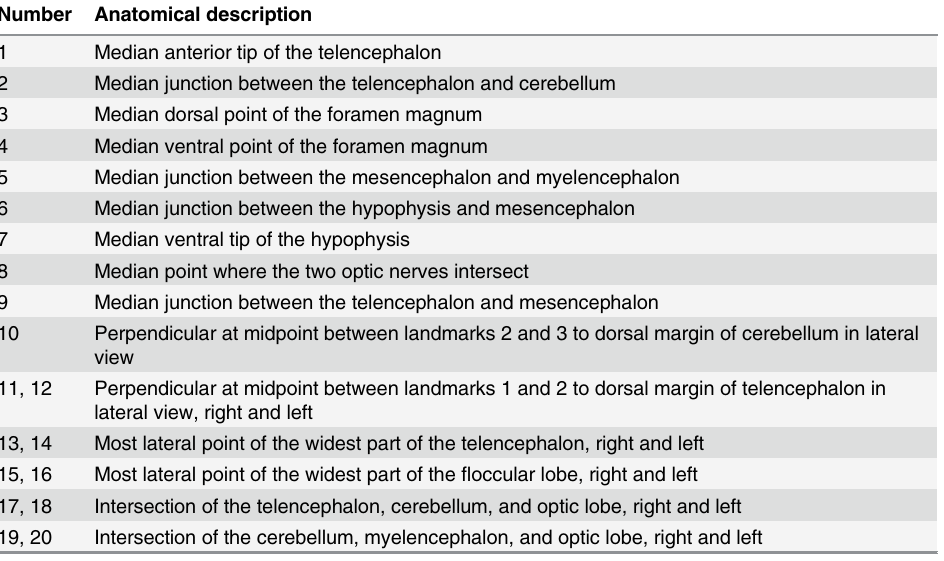
Table 2. Landmarks used (Fig 2) and anatomical descriptions (refer to Fig 2) for profiled anatomical